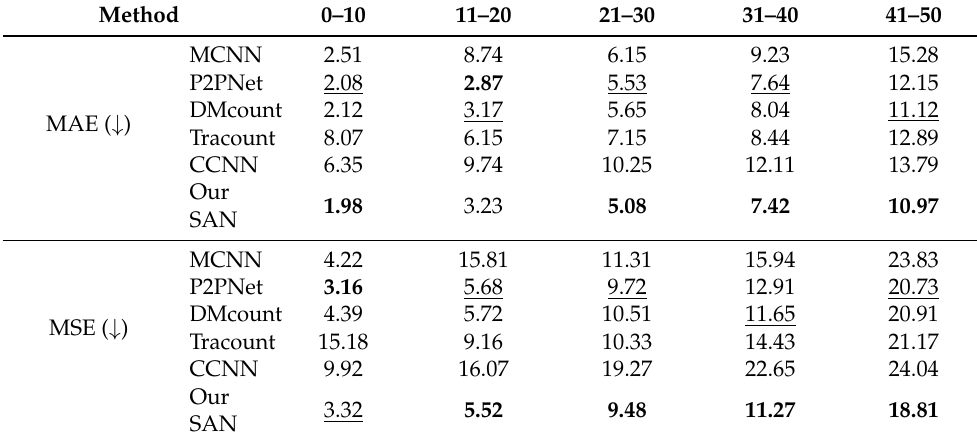
Table 1. Numerical comparison with multiple methods on TRANCOS datasets (where ↑ Higher is better and ↓ Lower is better). The best values are highlighted in boldface, and the second-best values are highlighted by underlines.